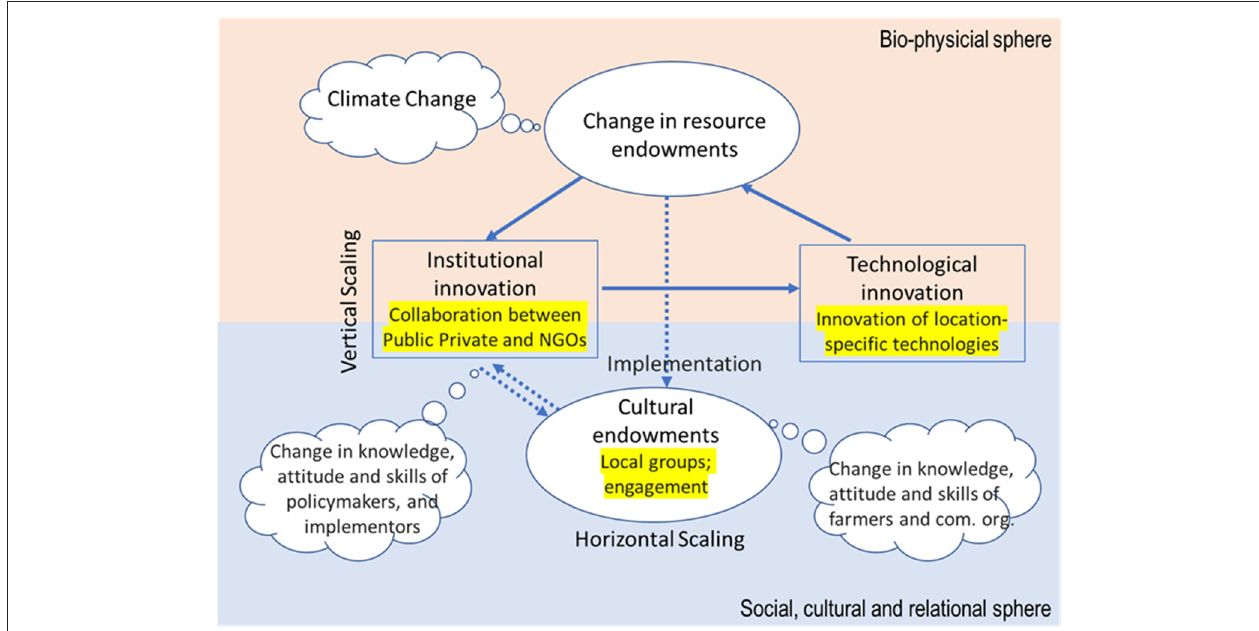
FIGURE 3 | Revised conceptual model illustrating interactions between institutional, cultural, and technological innovation in agriculture.